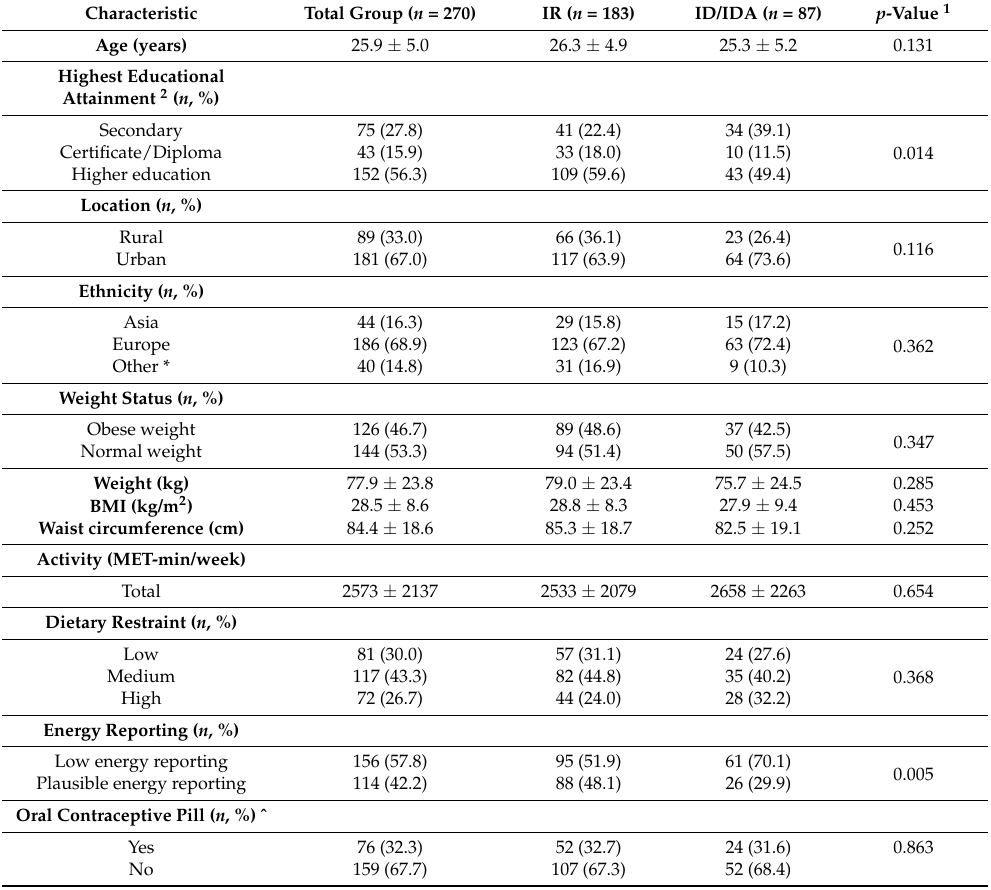
Table 1. Participant characteristics of IR and ID/IDA